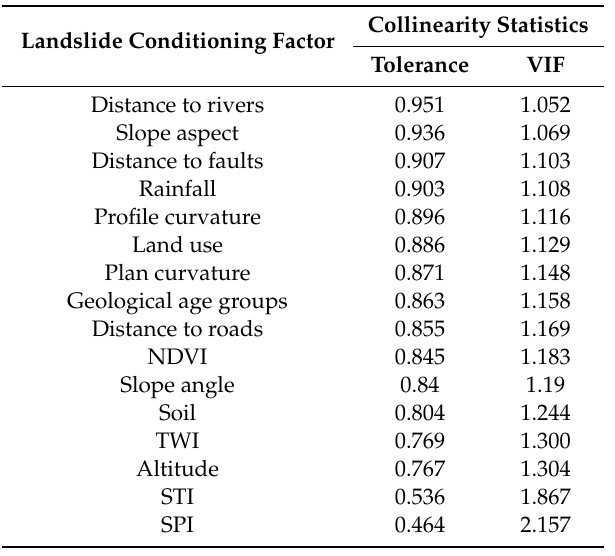
Table 1. Multicollinearity analysis in the current